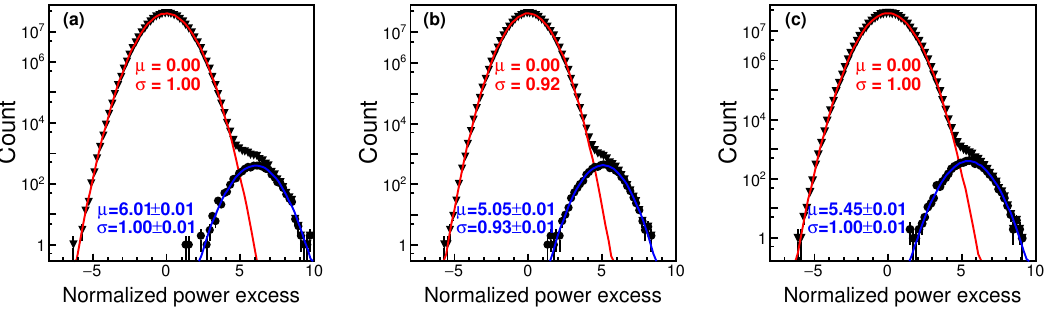
Figure 7 . The inverted triangles in (a), (b), and (c) are the distributions of the normalized power excess from all the frequency bins in the normalized grand power spectra from the 5000 simulated CAPP-8TB experiments, while the circles are those from a particular frequency bin where we put simulated axion signals on top of the CAPP-8TB background. (a) was obtained after subtracting the background with perfect fit; (b) and (c) with a 5-parameter fit; (c) incorporates the correlations between the co-adding frequency bins. Lines are a Gaussian